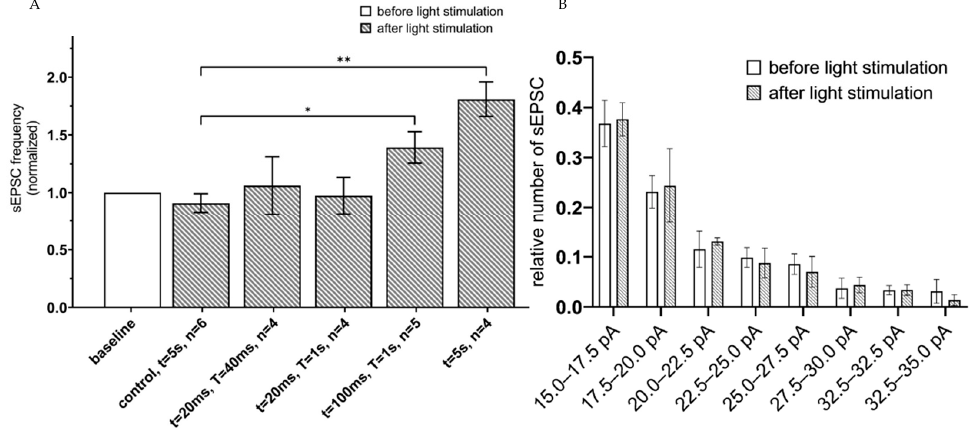
Figure 2. sEPSC changes in response to astrocyte activation using ChR2(H134R)–mCherry. ( A ) Values of the normalized frequencies of sEPSC of hippocampal neurons in the CA1 region after light activation (t = 20 ms, T = 20 ms; t = 20 ms, T = 1 s; t = 100 ms, T = 1 s; continuous light t = 5 s) of astrocytes expressing ChR2(H134R)—mCherry. The data are presented as the mean ± SEM, **: p < 0.01, *: p < 0.05. ( B ) distribution of sEPSC amplitudes before and after optogenetic (t = 5 s) activation of astrocytes expressing ChR2(H134R)—mCherry on the membrane. The data are presented as the mean ± SEM, n = 4.